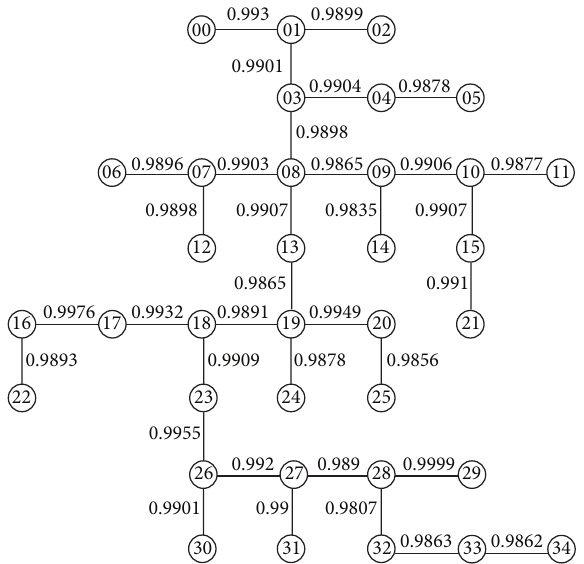
Figure 2: An example tree with a probability weight on every